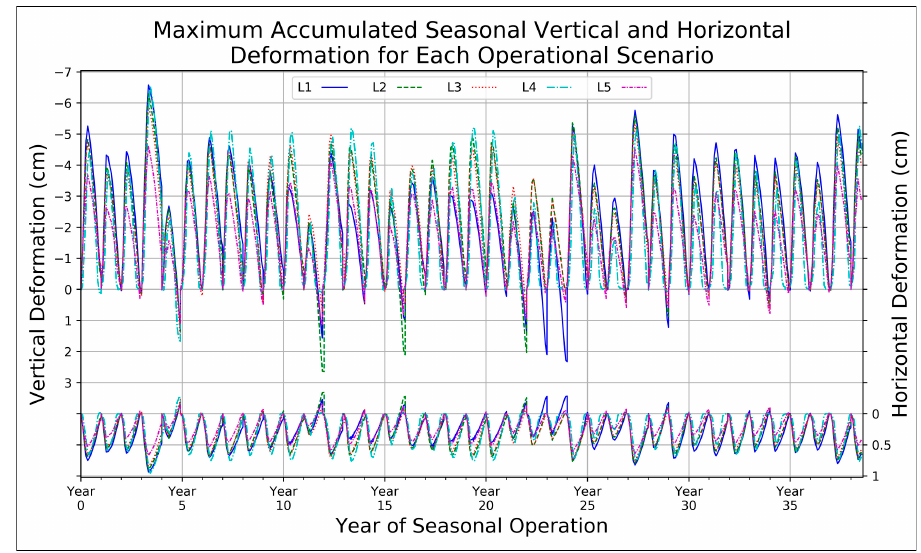
Figure 7. Maximum seasonal accumulated daily vertical and horizontal displacements for all five operational scenarios from the full 39-year datasets. These plots track the daily displacement at the location of the annual season’s overall maximum accumulated vertical and horizontal displacement for each scenario. The plotted data are the accumulated vertical and horizontal displacements for each seasonal cycle in the full 39-year dataset. Note that the displacement at the beginning of each season reverts back to zero, and the subsequent seasonal displacements are accumulated from that start point until the end of the season. The top and bottom portions of the plot correspond to vertical and horizontal displacement, respectively. We also note that the y-axis scale for the horizontal displacement is half that of the vertical displacement.